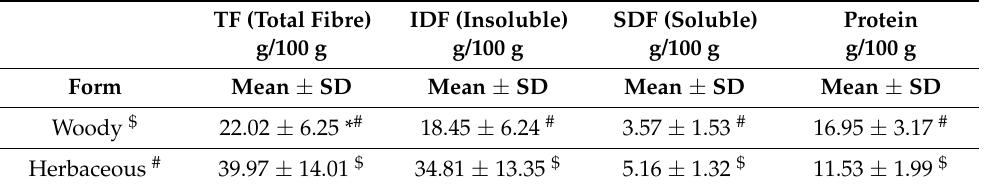
Table 4. The content of dietary fibre (total, soluble and insoluble fractions) and total protein in woody and herbaceous plant .